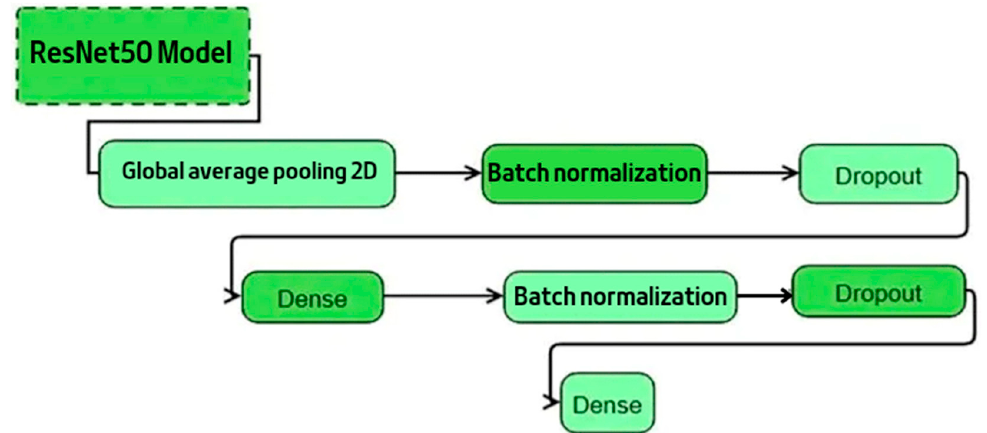
Figure 7. Architecture of the transfer learning with ResNet50 model.